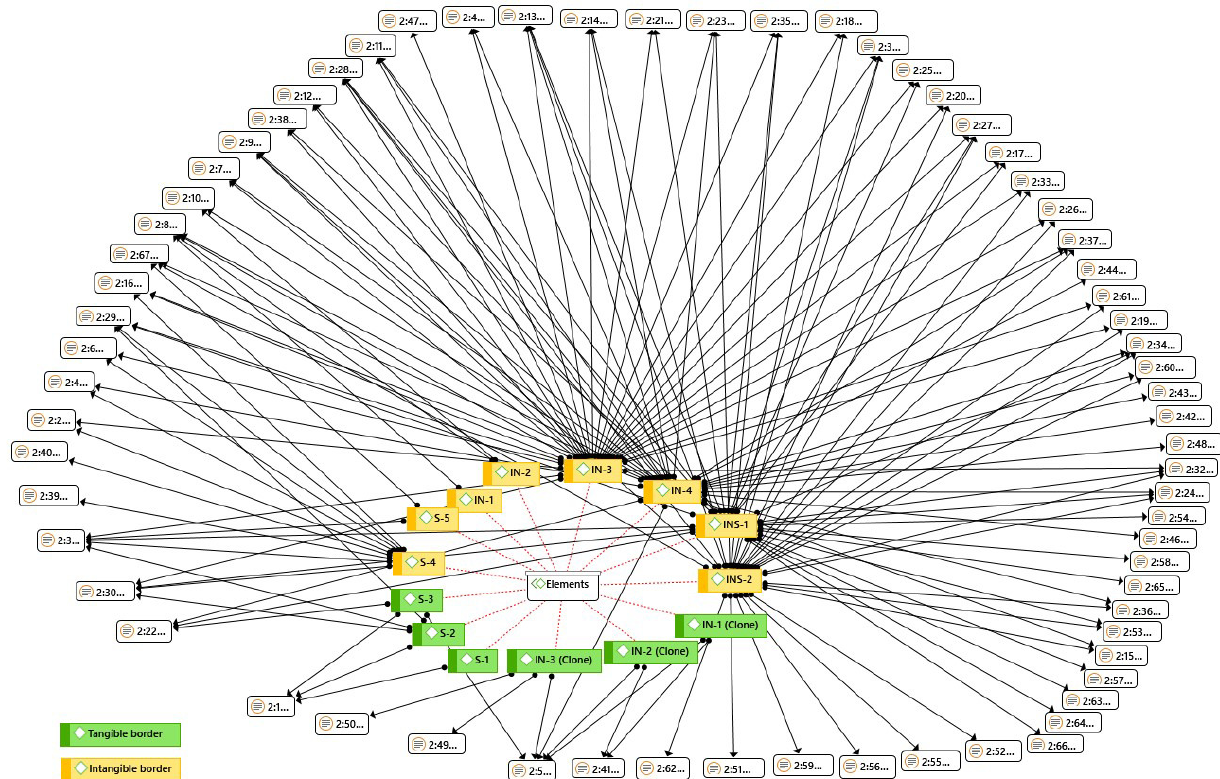
Figure 2. A network between codes and respondents’